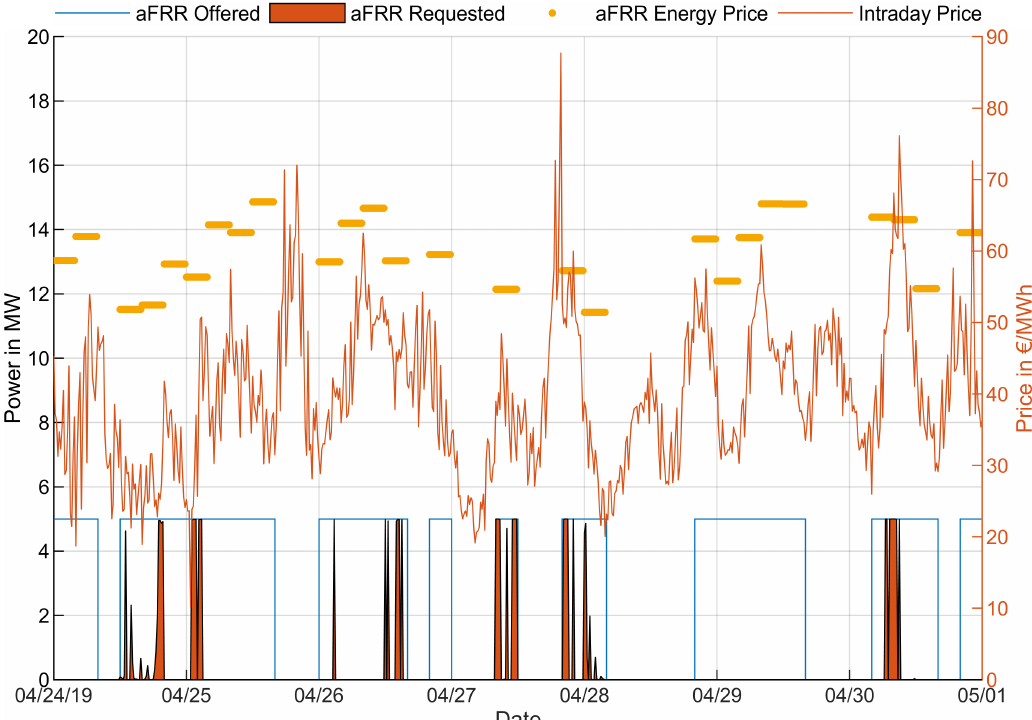
Figure 3. The diagram shows on the left y -axis the power capacity offered and awarded for aFRR, the aFRR power that was requested. On the right y -axis the energy prices for aFRR and the intraday market are